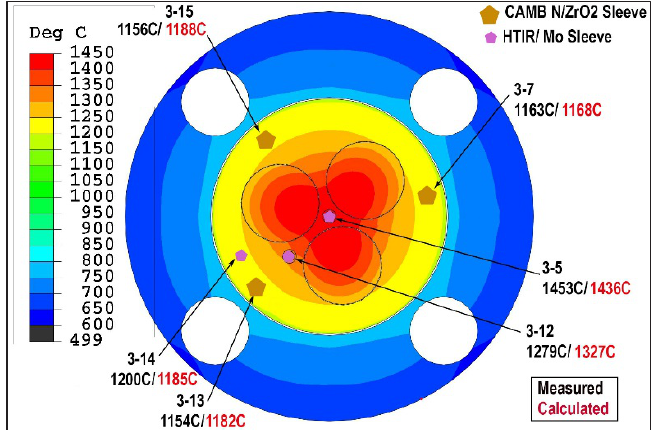
Fig. 6. Measured vs Calculated Temperatures for Capsule 3 Early in First Irradiation